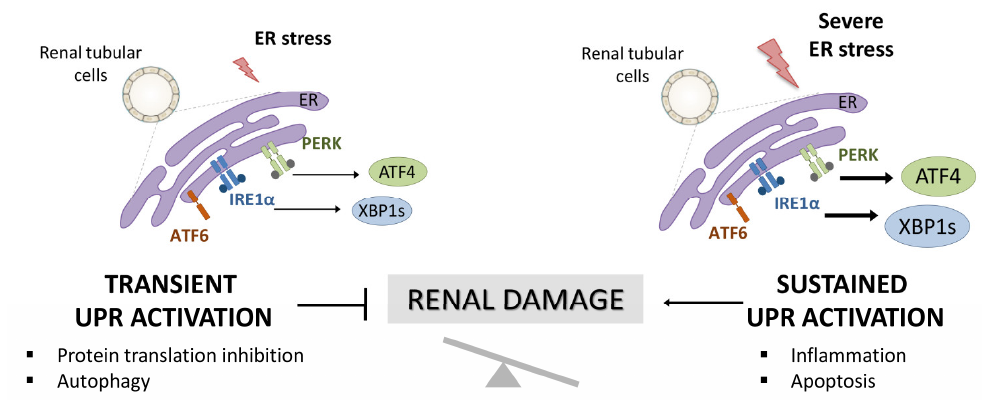
Figure 1. Activation of UPR in renal tubular cells and involvement in renal damage. Accumulation of unfolded proteins in the ER triggers the activation of the UPR pathway aimed at resolving the damage (transient UPR activation or adaptive UPR). However, when this UPR activation is sustained over time (maladaptive UPR), PERK/ATF4 and IRE1 α /XBP1 UPR branches initiate pathological processes, such as exacerbated inflammation and apoptosis that aggravate the renal damage.